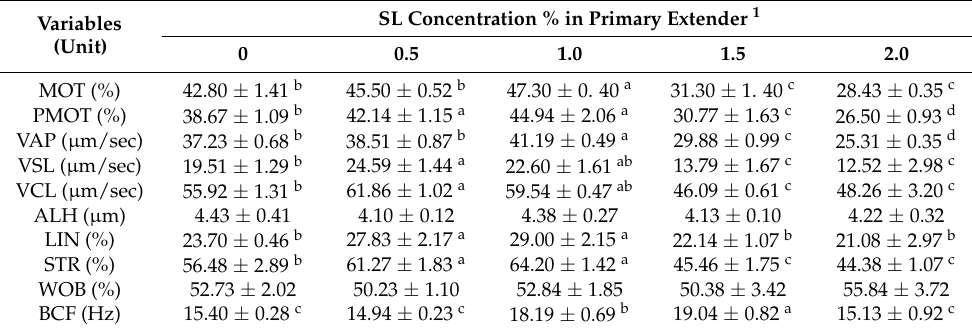
Table 1. The effect of different concentrations of soybean lecithin (SL) on post-thawed rooster sperm motion parameters (n = 20 roosters and n = 95